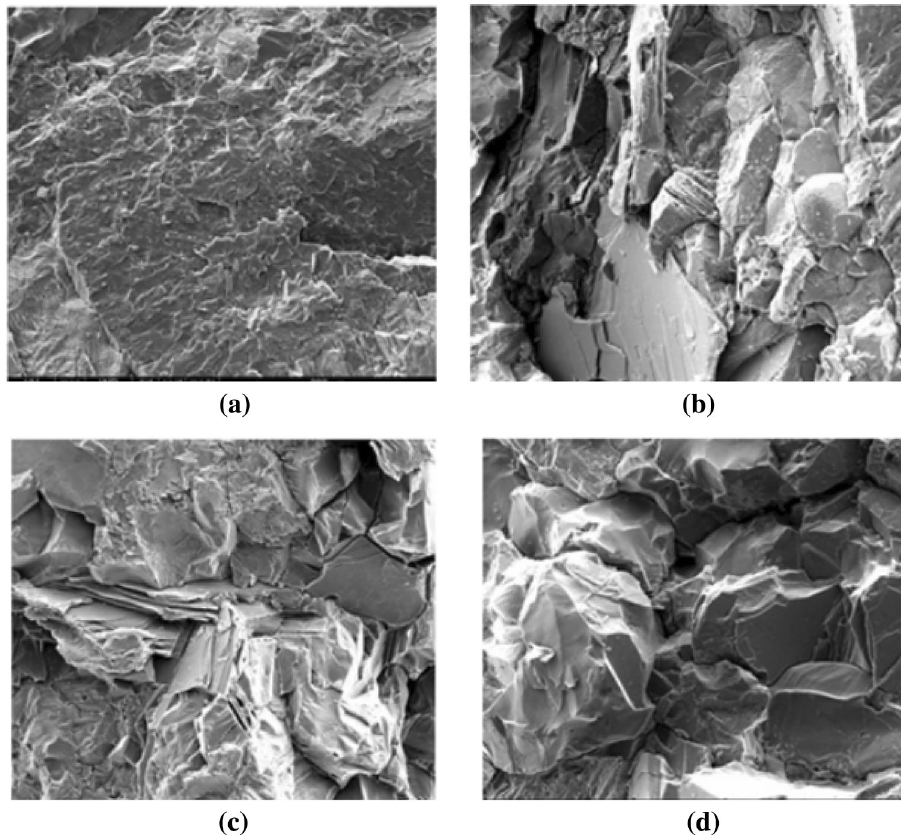
Fig. 9 Morphology of sandstone at different temperatures (Yin et al.